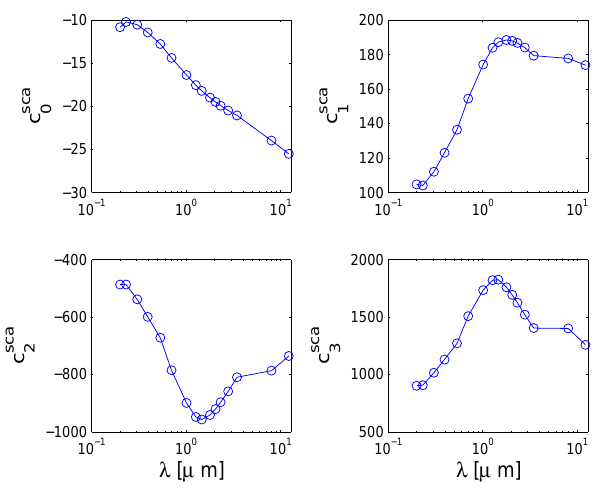
Fig. 6. Spectral dependency of the cubic fitting coefficients of C sca .